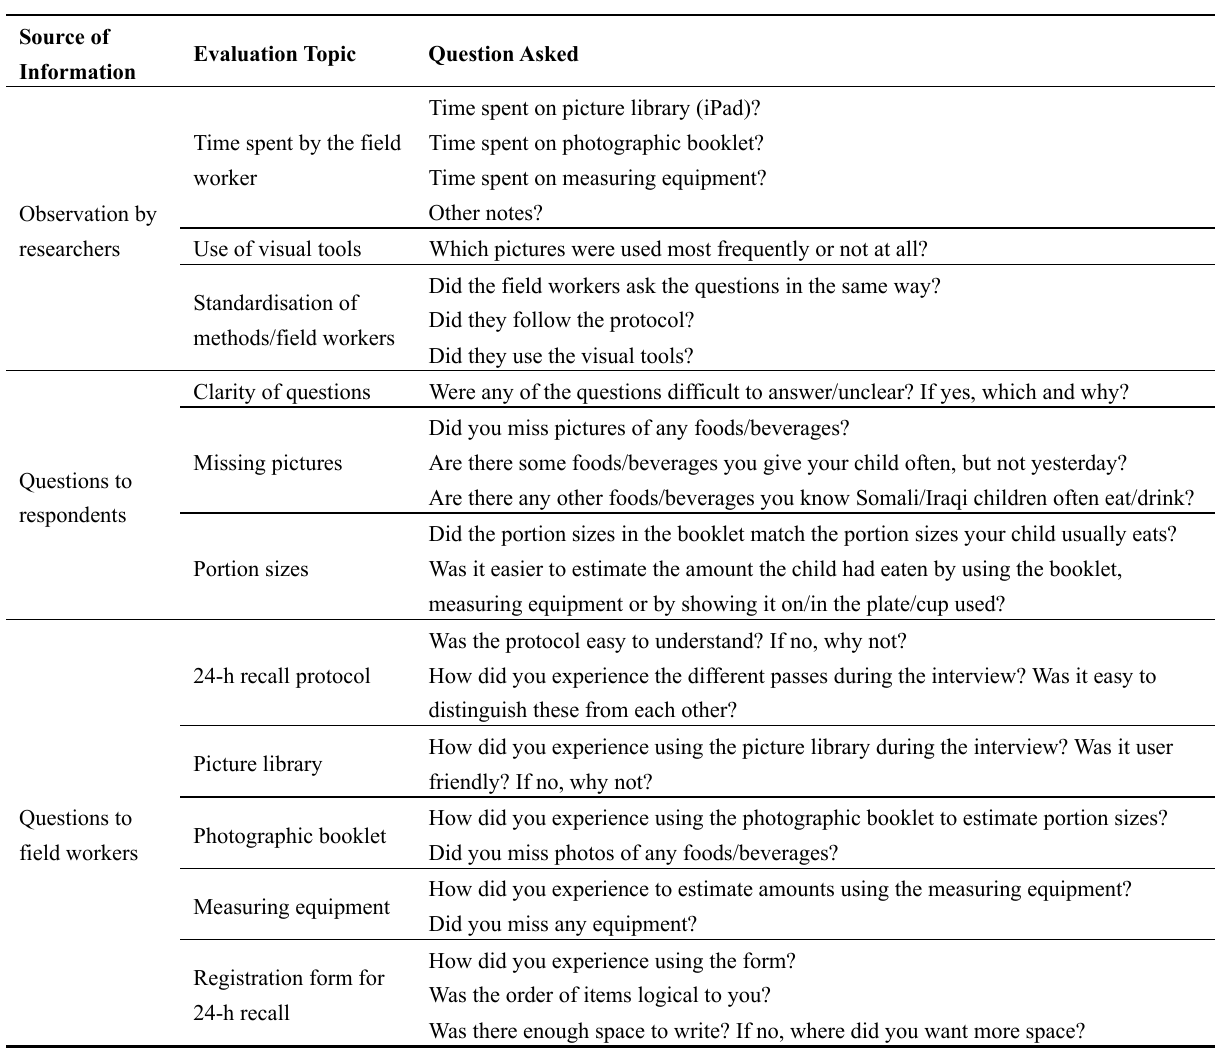
Table 2. Evaluation form for the pilot